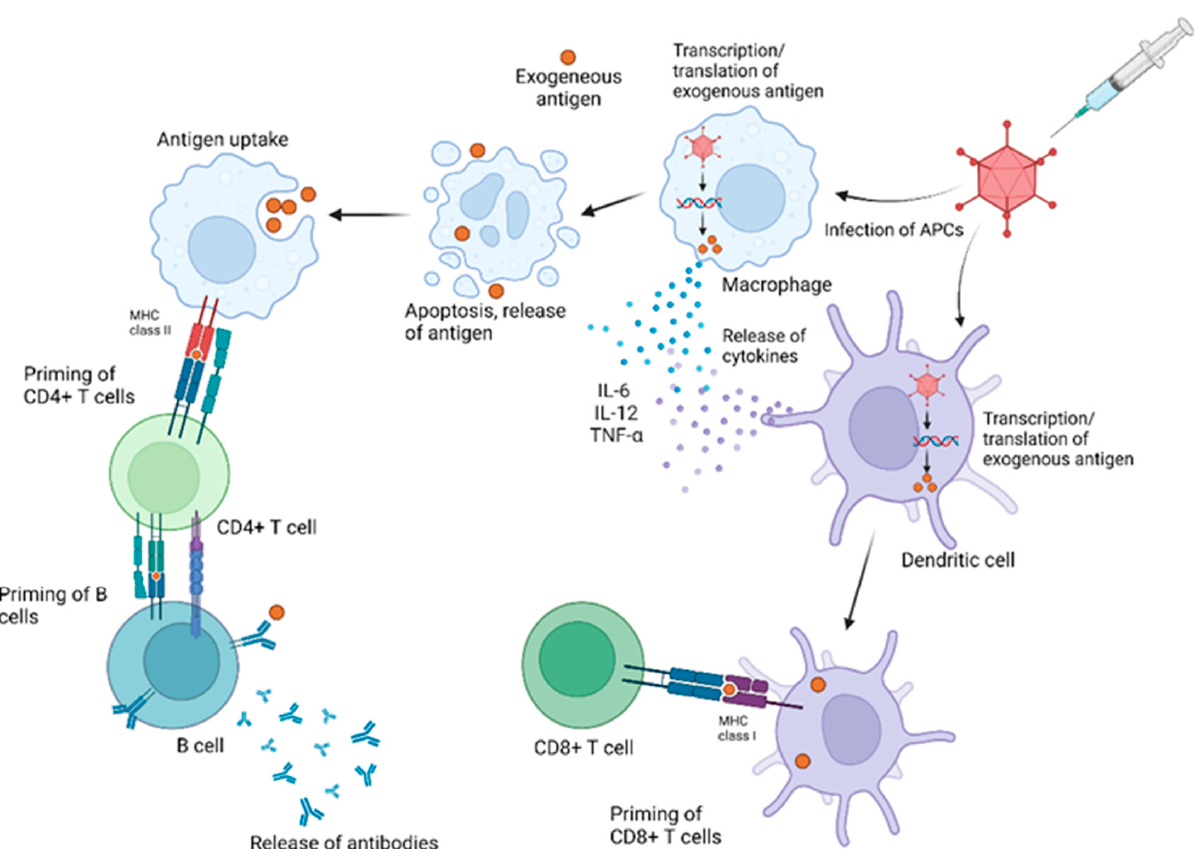
Figure 1. Immune responses elicited by adenovirus (AdV)-vectored vaccines. The AdV vector infects multiple cell types, including antigen-presenting cells (APCs) such as macrophages and dendritic cells (DCs). Once infected, these cells produce cytokines such as IL-6, IL-12, and TNF- α . Within DCs, transcription and translation of the antigen encoded in the AdV vector results in the presentation of the antigen on MHC class I to CD8+ T cells. Infected macrophages, and other cell types, which die by apoptosis or other means, release the antigen into the extracellular milieu, where the antigen can be taken up by other macrophages and presented on MHC class II to CD4+ T cells. CD4+ T cells, among other roles, prime B cells to produce antibodies against the antigen. Created with BioRen- der.com.